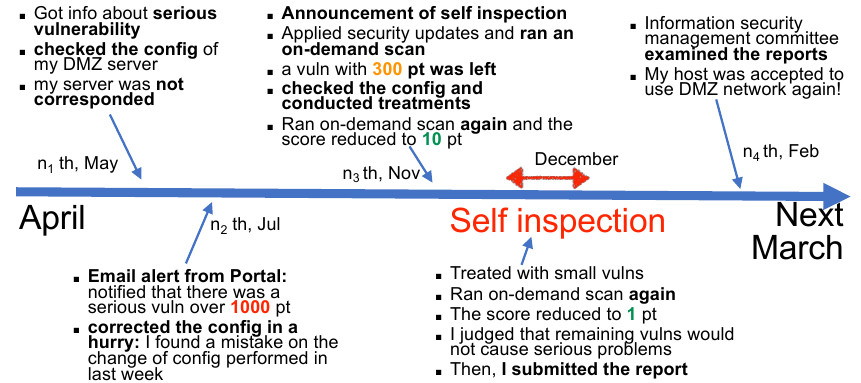
Figure 1: Various demands for DMZ hosts.